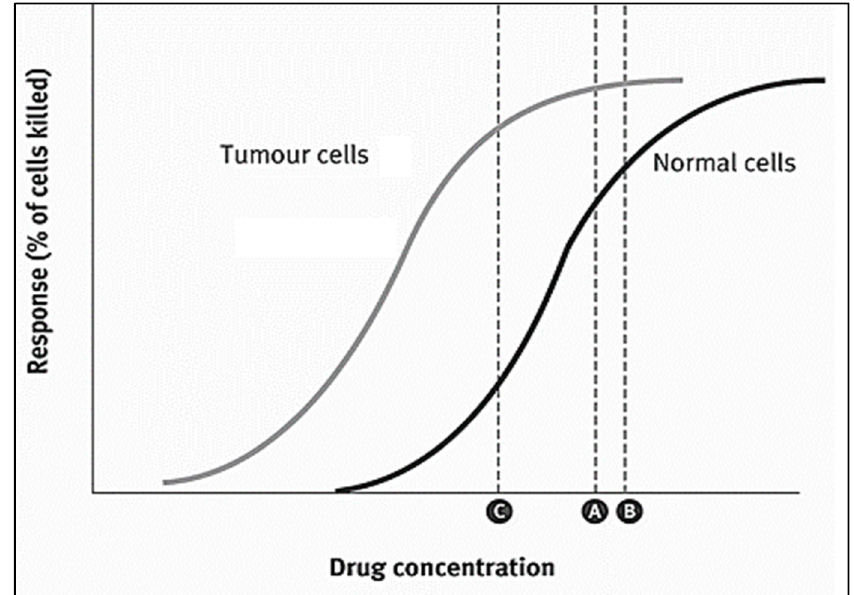
Figure 2. Dose responsive curve for chemotherapy drugs kills both tumor cells and healthy cells. The therapeutic dose ( A ) is close to the toxic dose ( B ). It is not safe to give this drug at a therapeutic dose. A safe dose ( C ) is chosen for administration to patients. Reproduced with permission from [14], Elsevier, 2008.